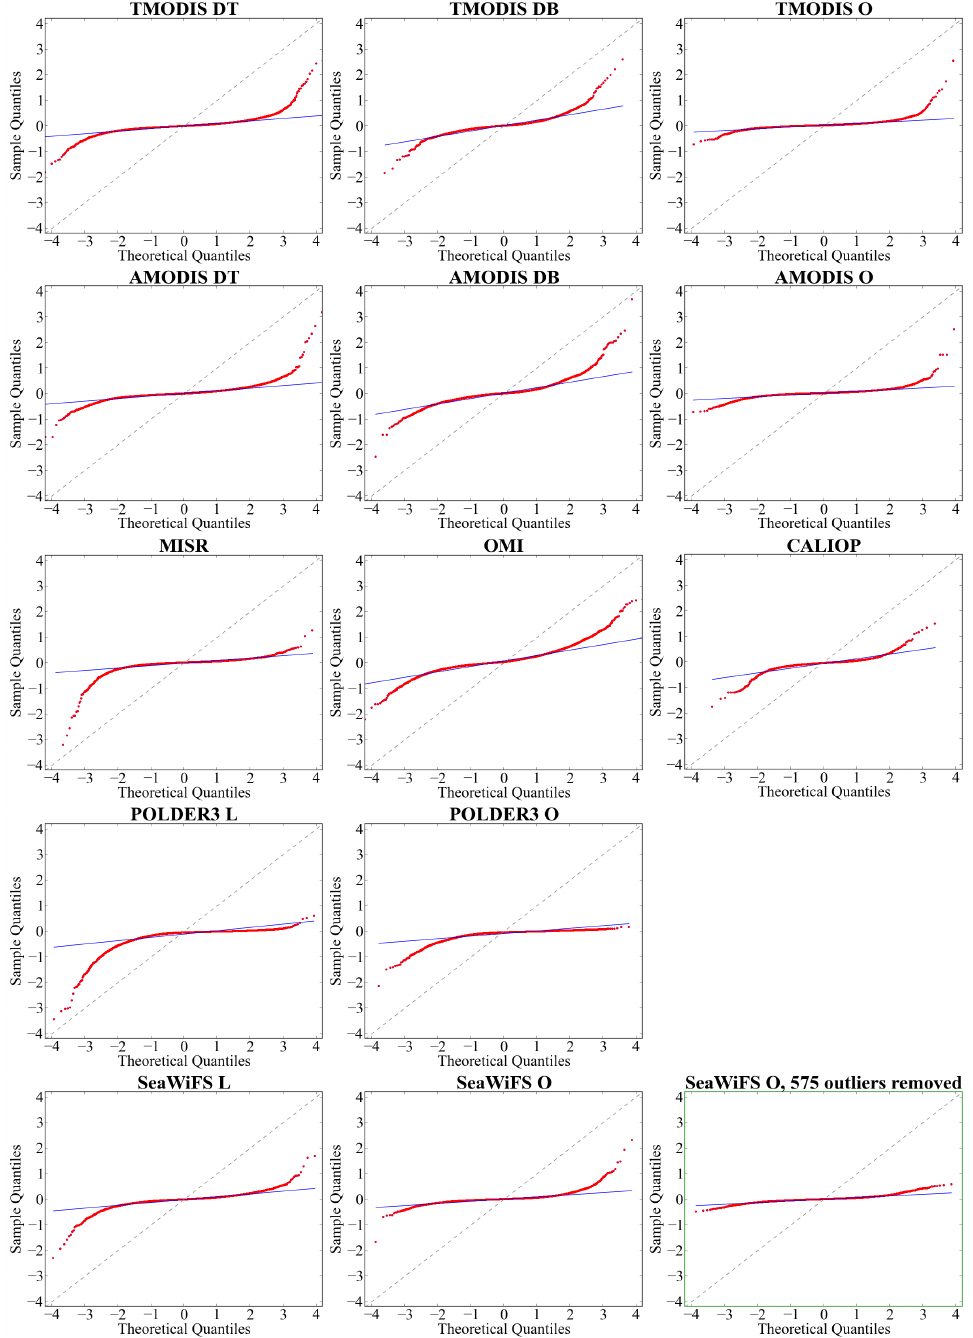
Figure 8. Normality of the difference between Spaceborne AOD and AERONET AOD. In each plot, points closely following the blue fitted line indicate the data that are approximately normally distributed. Curvatures around the center of the straight line represent the departure from the normality and indicate a presence of possible outliers, particularly at the tails of the distributions. The difference in the slope and offset of the fitted blue line from the gray 1:1 line indicates a deviation from the standard location (i.e., mean=0) and scale (i.e., standard deviation=1) of the normal distribution. Satellite data were pre-screened by QA as explained in Section 4. Plot in the green frame demonstrates the results of the possible data outlier detection and removal procedure described in Section 5.